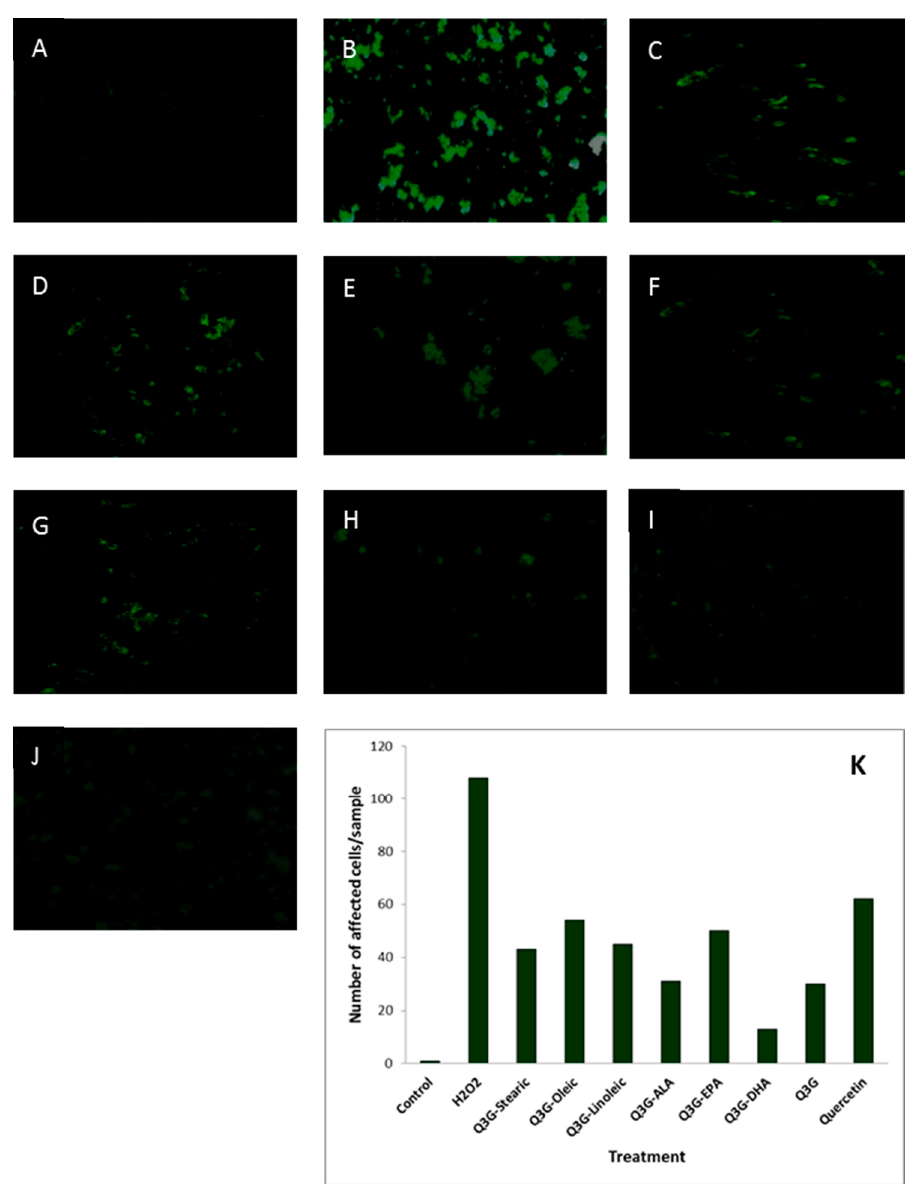
Figure 9. Effect of test compounds on H 2 O 2 -induced apoptotic cell death of WI-38 cells. ( A ) Untreated control; ( B ) Cells treated only with H 2 O 2 ; ( C ) Stearic acid ester of Q3G, ( D ) Oleic acid ester of Q3G; ( E ) Linoleic acid ester of Q3G; ( F ) ALA ester of Q3G; ( G ) EPA ester of Q3G; ( H ) DHA ester of Q3G; ( I ) Q3G; ( J ) Quercetin; ( K ) Number of apoptotic cells in relation to the treatments. Cells were